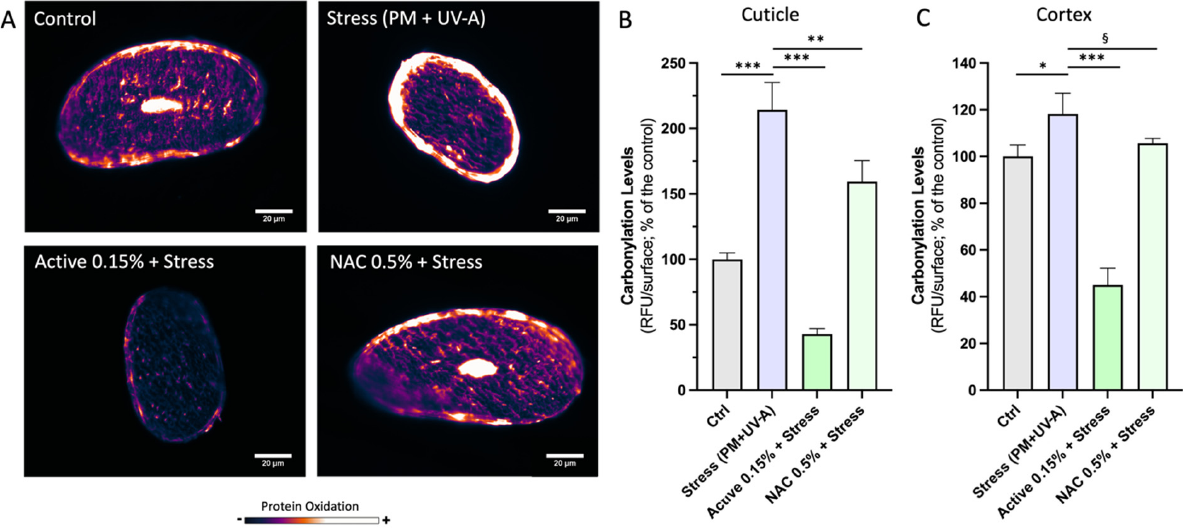
Figure 5. Protection of hair fibers carbonylation by anti-oxidants. ( A ) The in situ carbonylation levels on hair cross sections are visualized as a color range (from dark color for low levels to bright colors for high levels of carbonylation). The presence of the stress (PM + UV-A) induced significant increase of carbonylation in both ( B ) cuticle and ( C ) cortex regions. The presence of NiBDPP (active 0.15%) or N-acetyl cysteine (NAC 0.5%) preserved hair fibers from stress-induced carbonylation. Statistics ANOVA followed by Dunnett’s post-hoc test versus stress (two-ways; § p < 0.1, * p < 0.05, ** p < 0.01, *** p < 0.001).